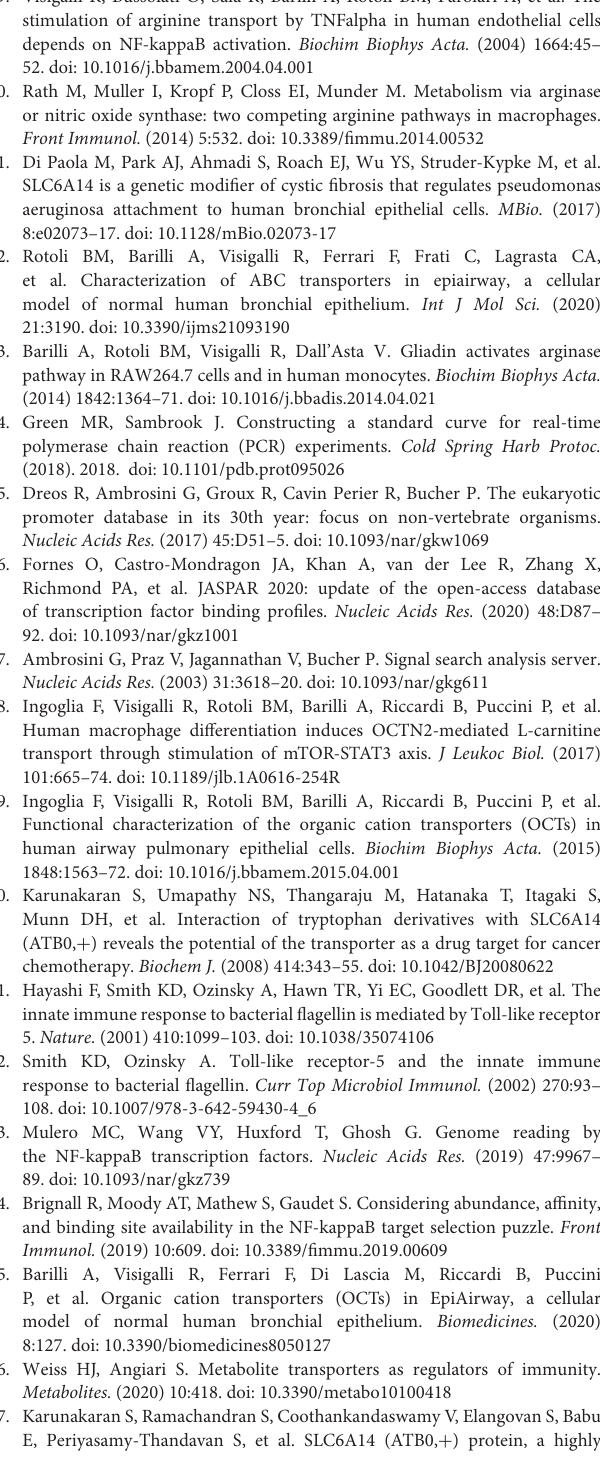
presented as mean ± SEM. Monocyte-derived macrophages (MDM) were obtained from human monocytes after 5 day differentiation in the presence of 50ng/ml